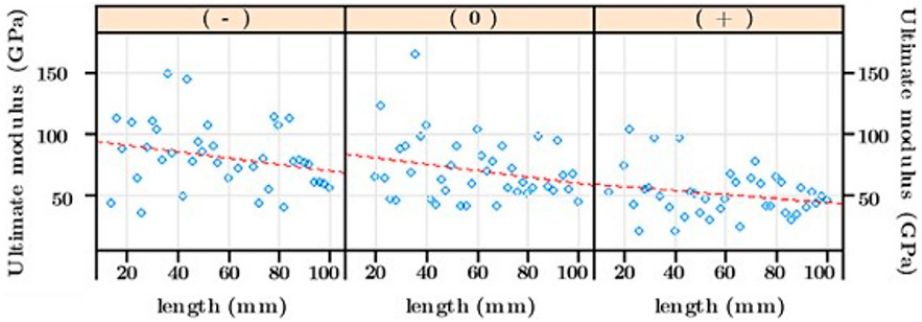
Figure 2. Ultimate modulus of flax